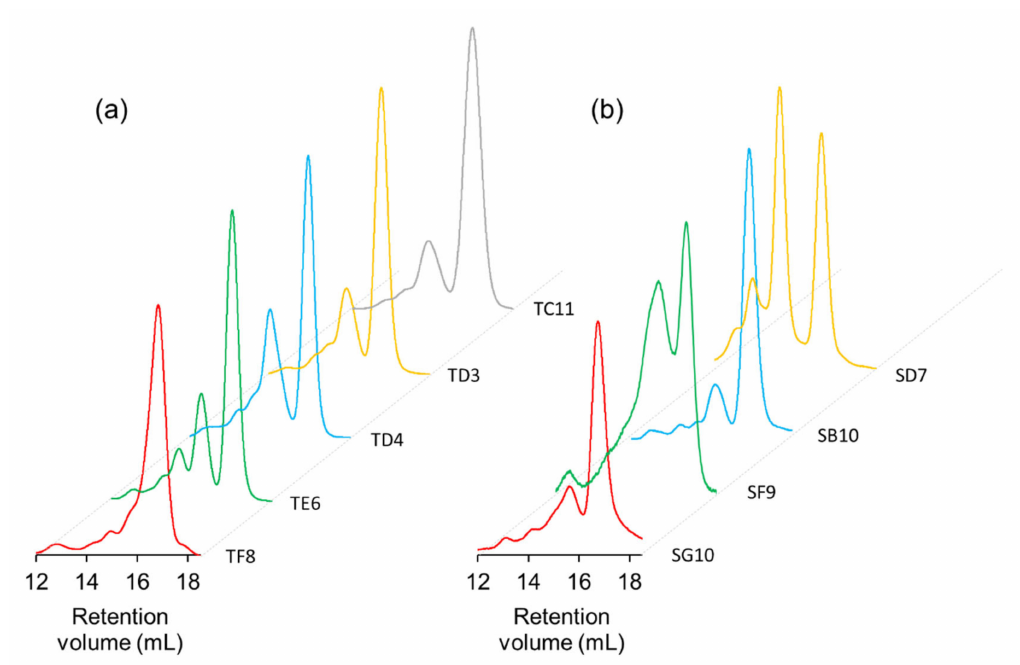
Figure 7. SEC analysis of scFv clones from ( a ) OPAL-T and ( b ) OPAL-S. Monomeric scFv was eluted at retention volume ~17 mL. Clones show varying degrees of dimerization/aggregation (approximately 14–16 mL retention